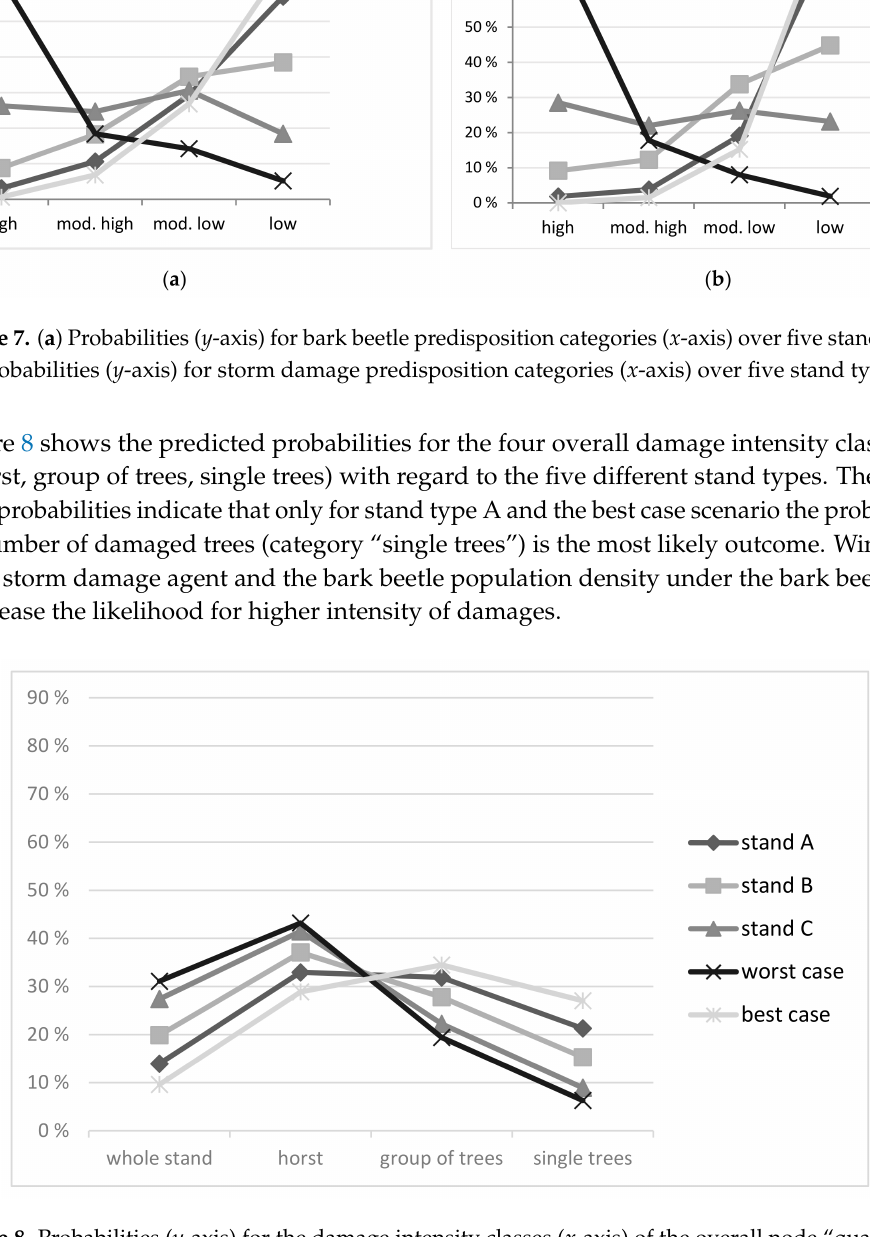
Figure 8. Probabilities ( y -axis) for the damage intensity classes ( x -axis) of the overall node “quantity of damage” for the five stand types. Intensities are defined with damage class on stand level scale (where “horst” defines damages > a “group of trees” in a scale not more than 0.5 ha in size and “group of trees” defines damages to more than five trees within a radius of tree